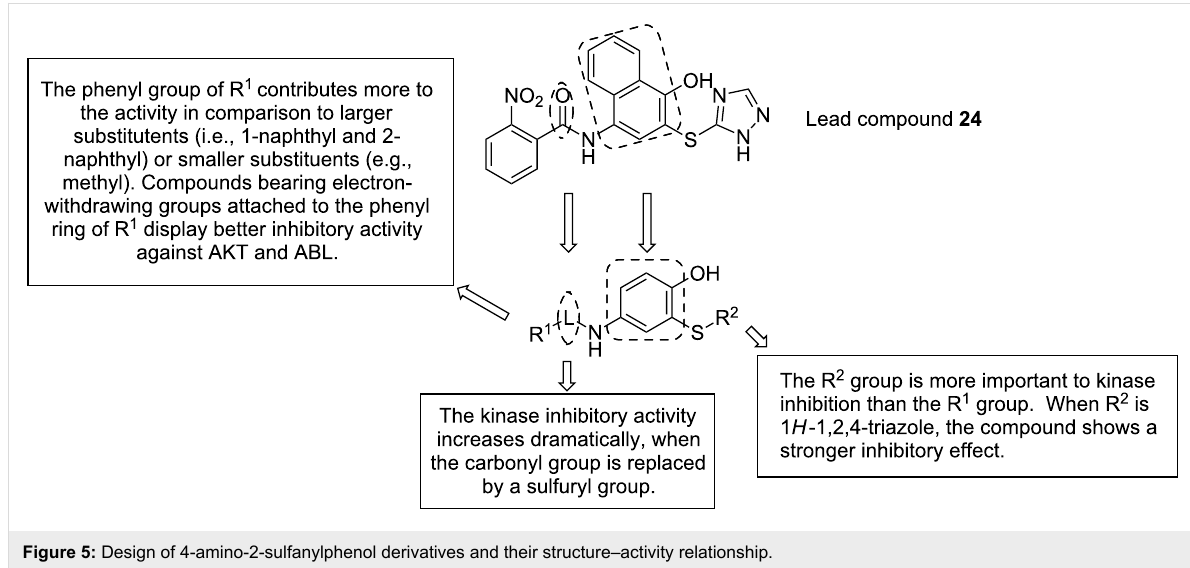
Figure 5: Design of 4-amino-2-sulfanylphenol derivatives and their structure–activity relationship.